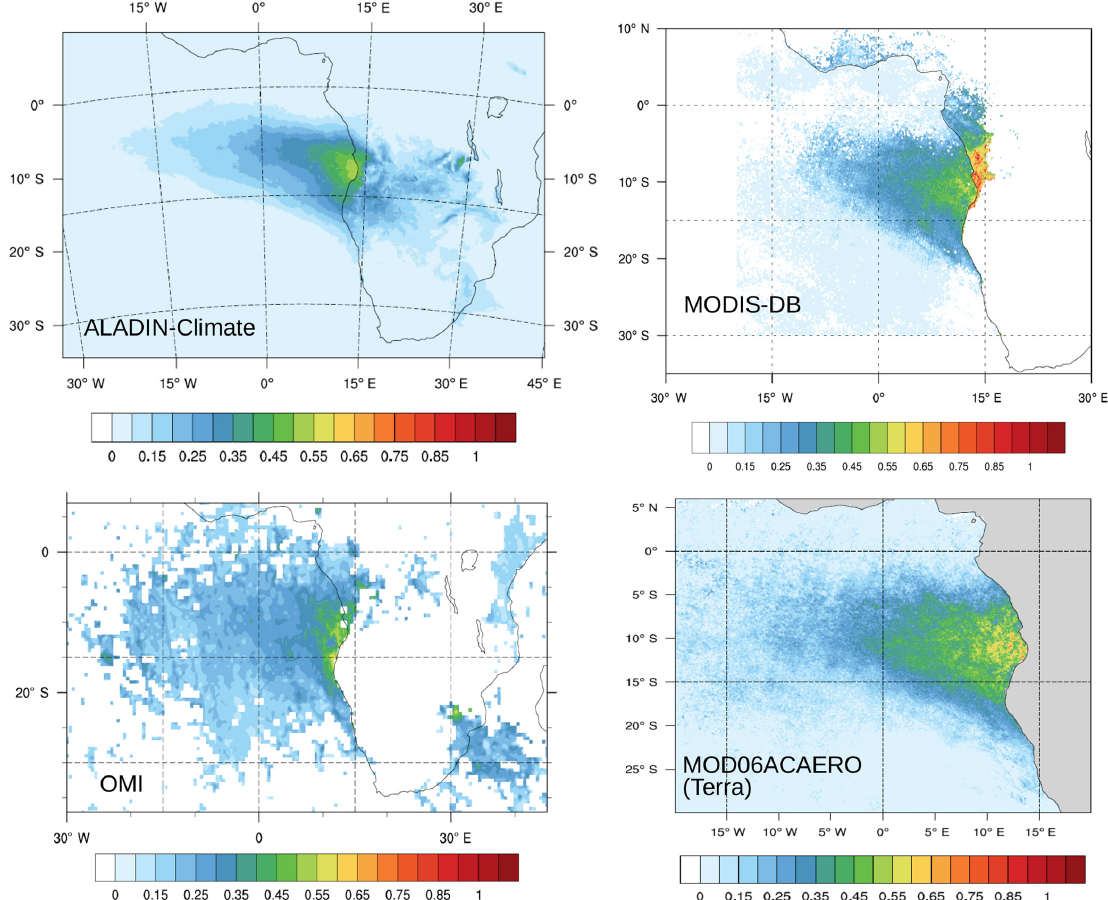
Figure 6. Total monthly averaged ACAOD (at 550nm) for September 2016 simulated by the ALADIN-Climate (10:30 and 13:30UTC outputs only are used) model and derived from MODIS (Deep Blue and Meyer retrievals) and OMI